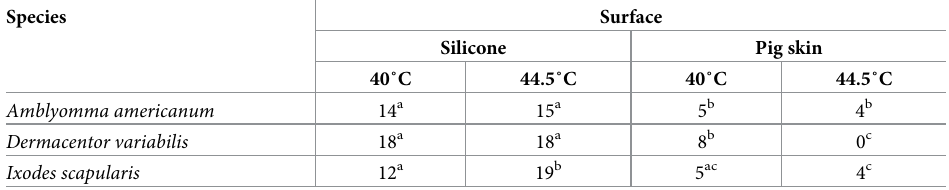
Table 1. Number of nymphal ticks losing contact with platform within 3 minutes of immersion, out of 20 individ- uals tested for each combination of species, test surface, and temperature. Species Surface Silicone Pig